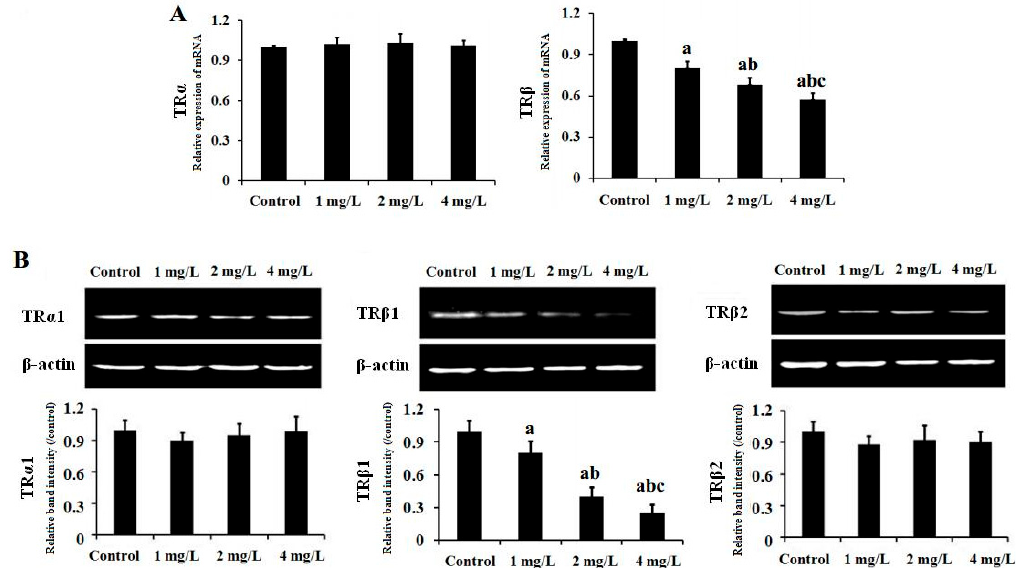
Figure 6. Effect of As exposure on gene ( A ) and protein ( B ) expression of TR in cerebellar tissue of mice. Adult male mice exposed to 0, 1, 2, and 4 mg/L As 2 O 3 in drinking water for 60 days. After the treatment, the expression of the TR gene and protein (three isoforms,TR α 1, TR β 1 and TR β 2) was analyzed by real time RT-PCR and western blot, respectively. The relative abundance of TR mRNA and protein was determined by the ratio of sample to β -actin. Data obtained from six separate analyses are expressed as mean ± SD ( n = 6 for each group). a p < 0.05 significantly different compared with the control group; b p < 0.05 significantly different compared with the 1 mg/L As 2 O 3 -treated group; c p < 0.05 significantly different compared with the 2 mg/L As 2 O 3 -treated group.